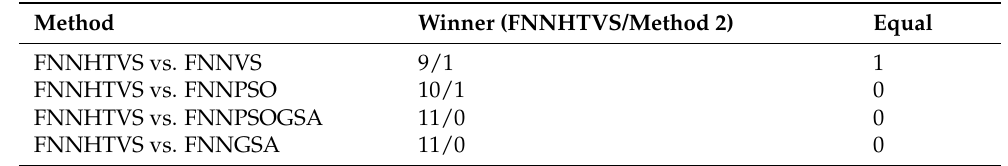
Table 6. WSR test results for the iris classification